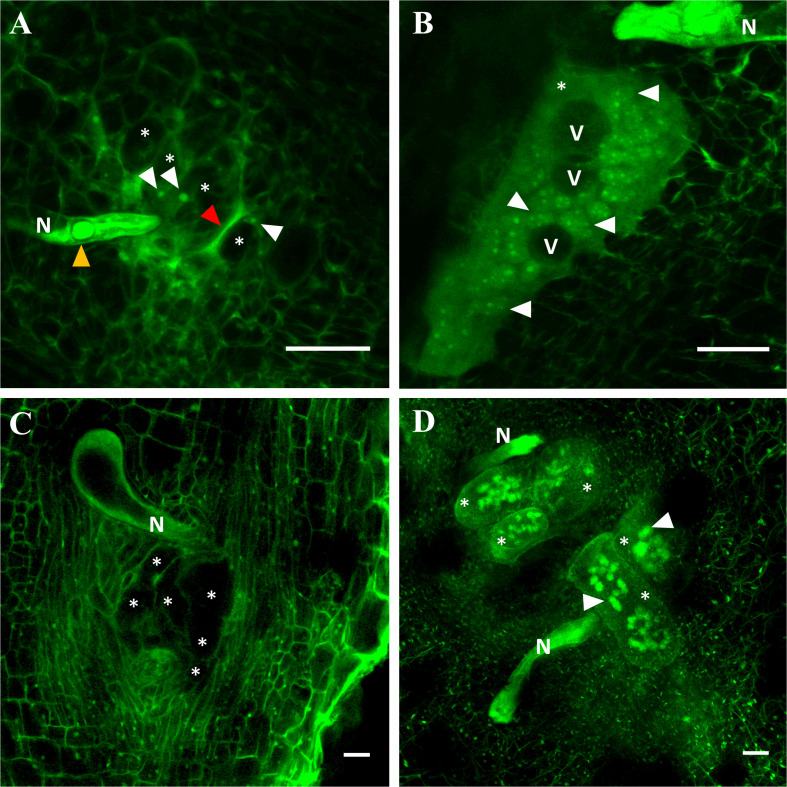
Laser scanning confocal microscope images of giant cells induced by Meloidogyne 15 days after inoculation in the resistant Cucumis metuliferus BGV11135 (A), the susceptible melon cv. Paloma (B), the resistant tomato cv. Monika (C) and the susceptible cv. Durinta (D). Nematode (N), vacuoles (V), giant cells (asterisk), some nuclei (white arrowhead), esophageal median bulb (yellow arrowhead) and necrosed area (red arrowhead) are indicated. Scale bar: 50 μm.